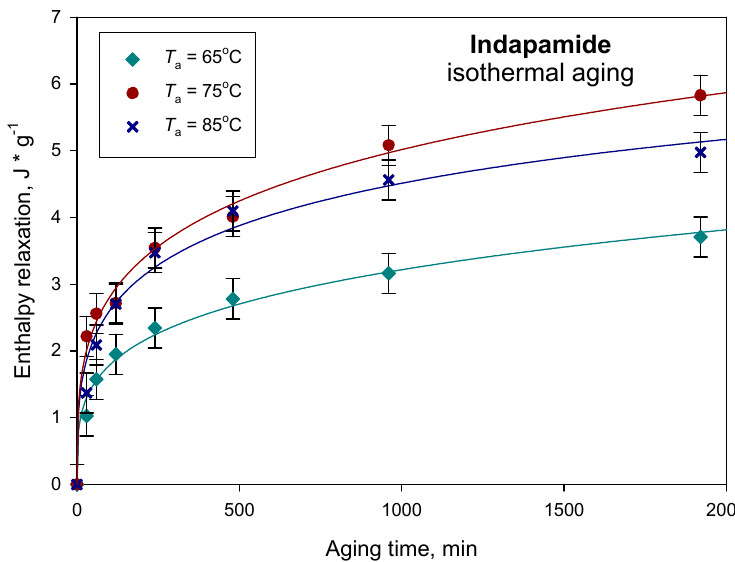
Figure 7. Enthalpy relaxation as a function of the ageing time for indapamide aged at 65, 75 and 85 °C.